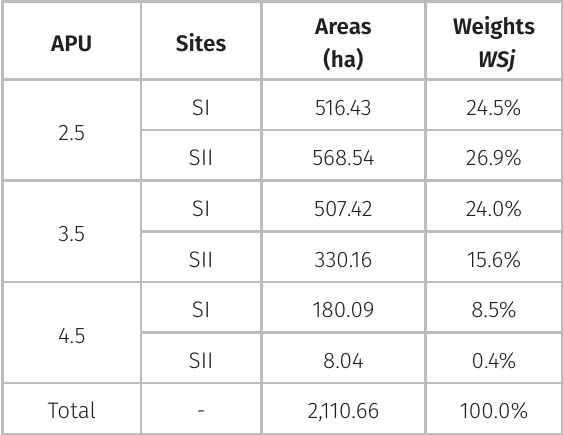
Table VI. Summary of areas and sites per APU for Eucalyptus sp. in the tropical region of